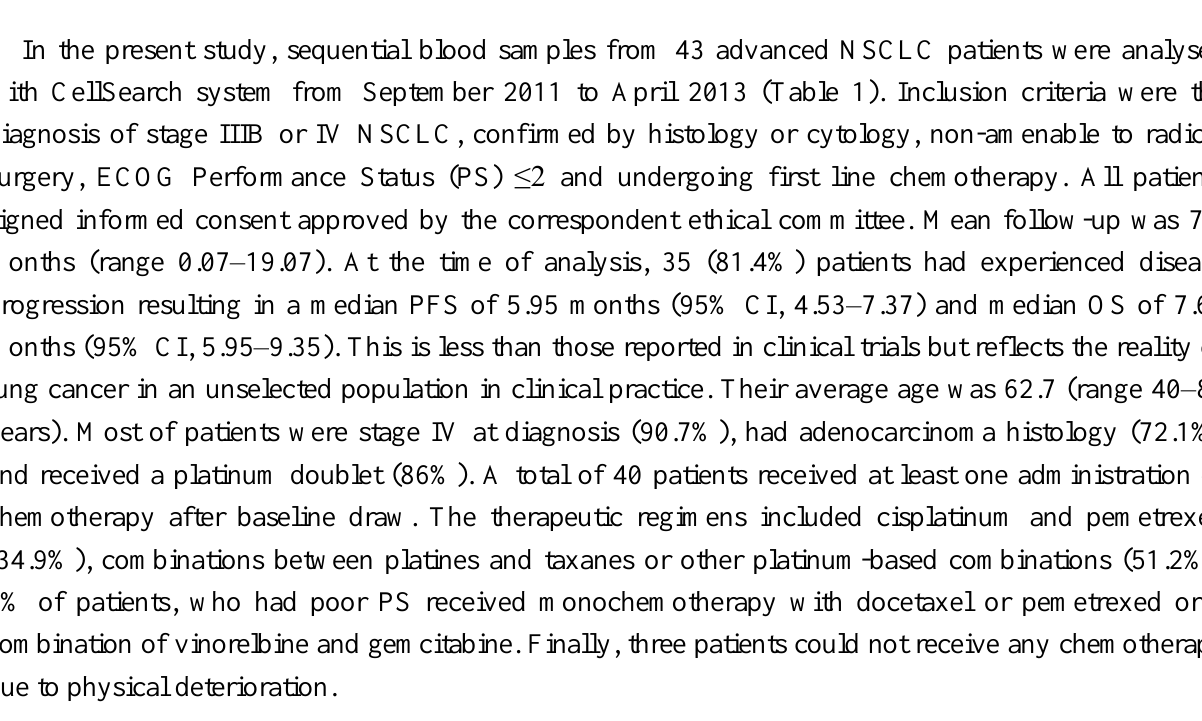
Table 1. Demographics of patients included in the